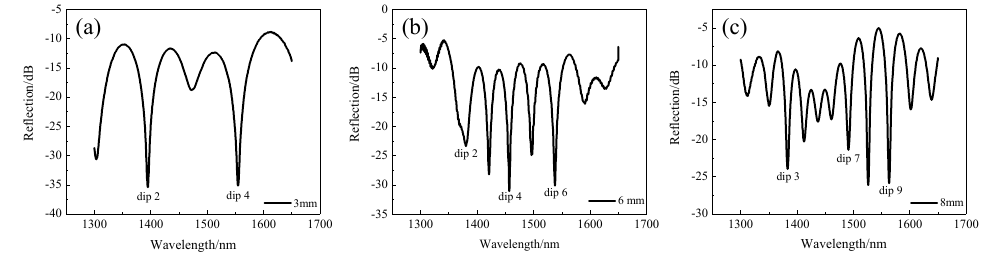
Figure 4. Reflection spectra of the MI structure with different lengths (L). ( a ) L = 3 mm; ( b ) L = 6 mm; ( c ) L = 8 mm.